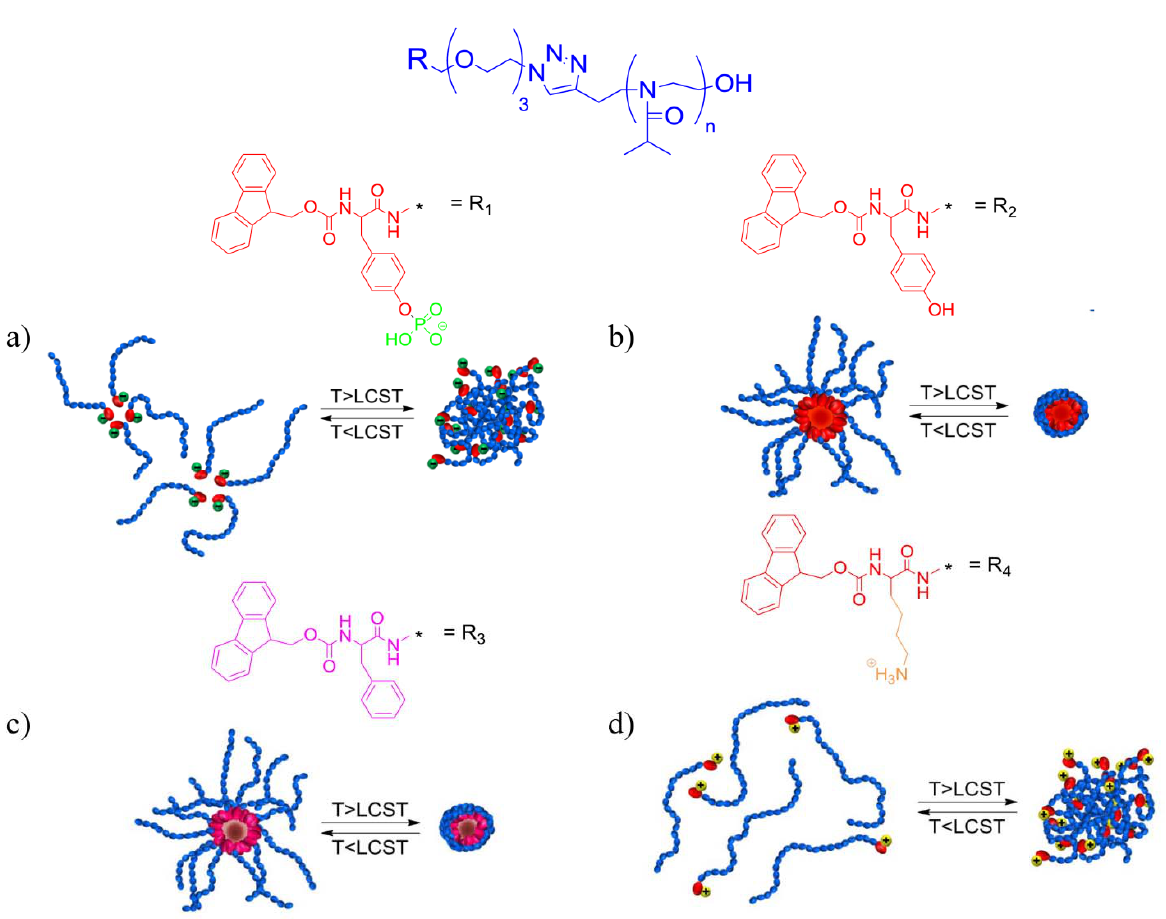
Figure 1. Schematic representation of self assembly behaviour of single component Fmoc-amino acid functionalised PiPrOx systems. ( a ) 1 forms unstable aggregates at room temperature but precipitates above the lower critical solution temperature (LCST) as shown for the unfunctionalised polymer; ( b ) 2 forms stable colloidal particles at room temperature which are kept when the temperature is increased; ( c ) 3 forms stable colloidal aggregates as seen for 2 both below and above the phase transition temperature; ( d ) 4 shows the same behaviour seen for the unfunctionalised polymer both at room temperature and above the LCST.